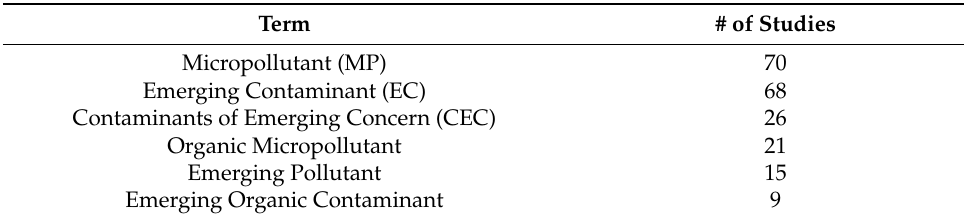
Table 1. Most frequently used terms to describe emerging contaminants from the literature search ( n = 180). Articles that referred to multiple terms or used terms interchangeably were recorded as using multiple listed terms. Term # of Studies Micropollutant (MP) 70 Emerging Contaminant